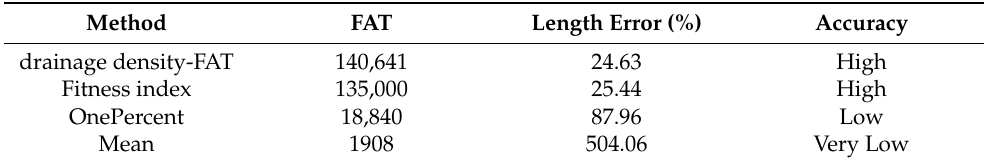
Table 5. The statistics for four river networks derived with four flow accumulation threshold (FAT) estimates (test area 2 of Qinghai